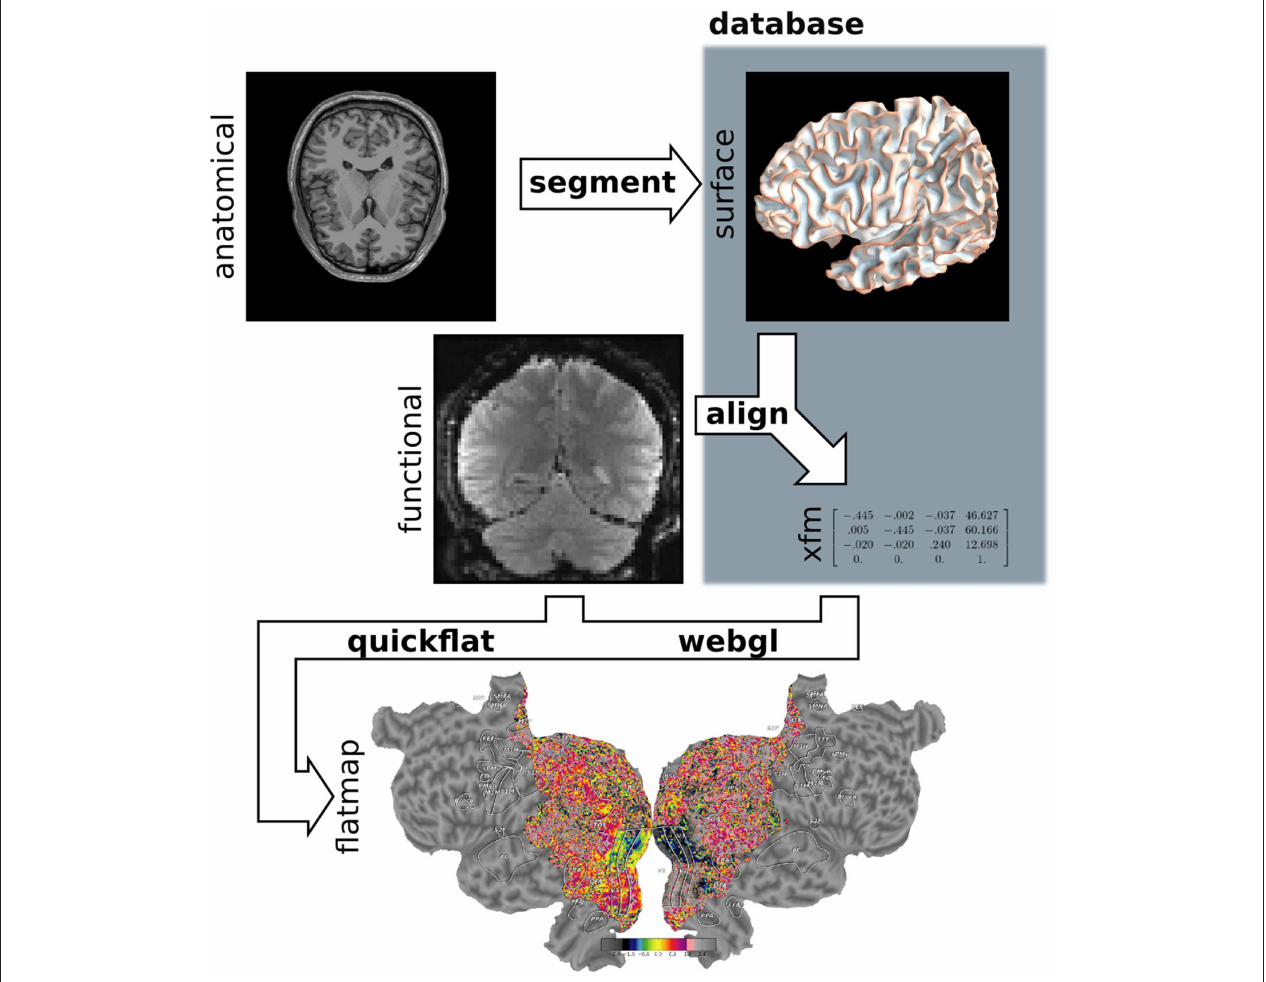
FIGURE 5 | Pycortex module diagram. Pycortex provides an integrated visualization toolkit for fMRI. Several pycortex modules are used to transform the user-provided anatomical and function data into an interactive visualization. The segment module integrates with Freesurfer to generate the surface. The align module uses the functional data and the surfaces to generate a transform. The quickflat and webgl modules generate static 2D flatmaps and interactive 3D visualizations, respectively. The overlays module is used to generate vertex-based ROIs and extract surface-defined volume ROIs.